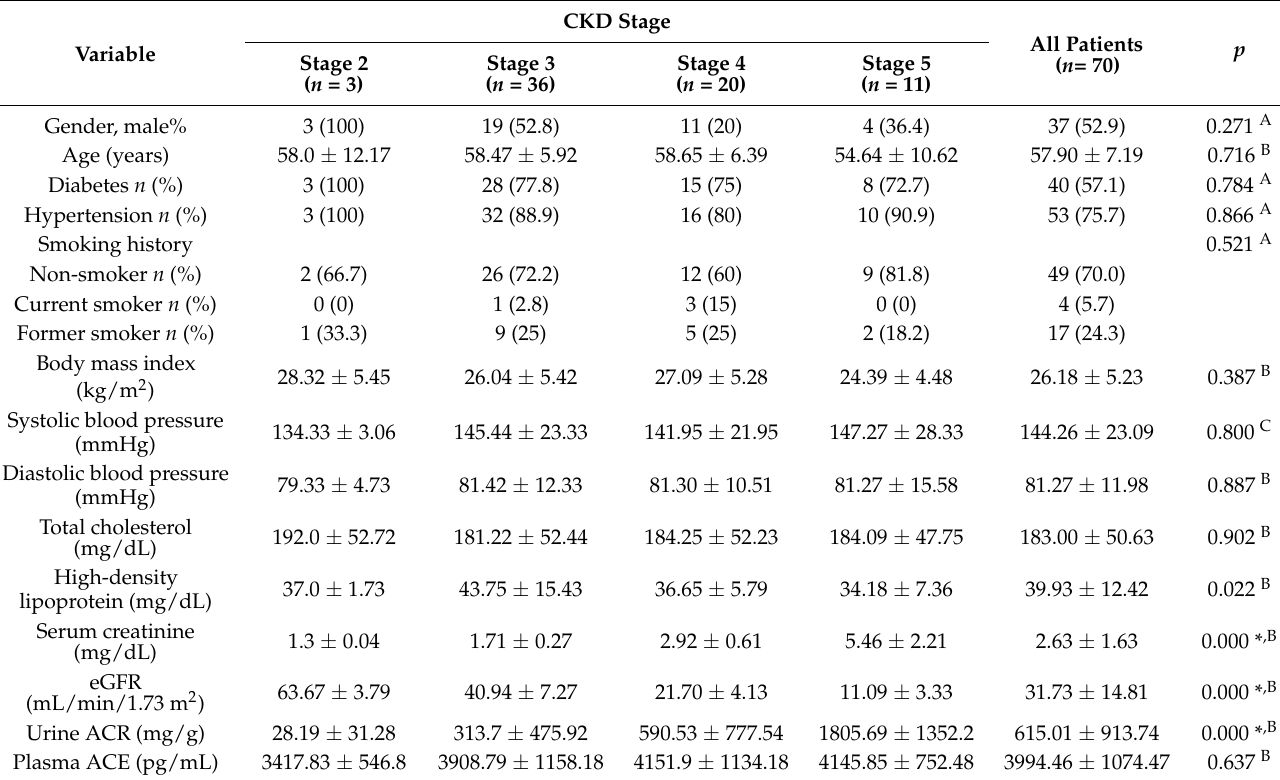
Table 1. Basic characteristics of the participants.